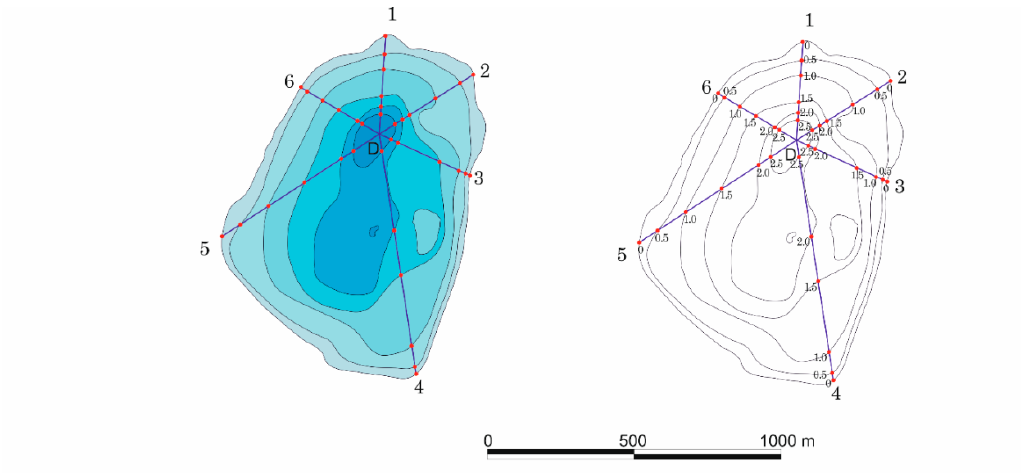
Figure 3. Radiuses used for partial gradients calculations.